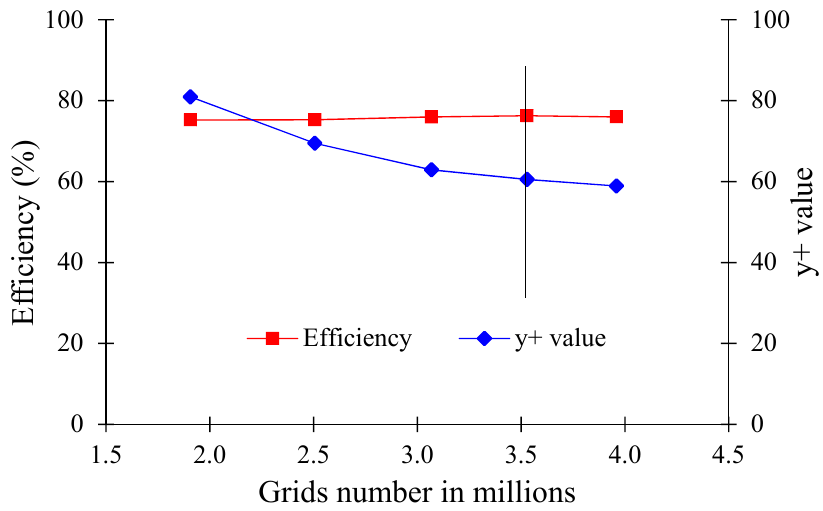
Figure 9. Grid dependency test for SCP model.